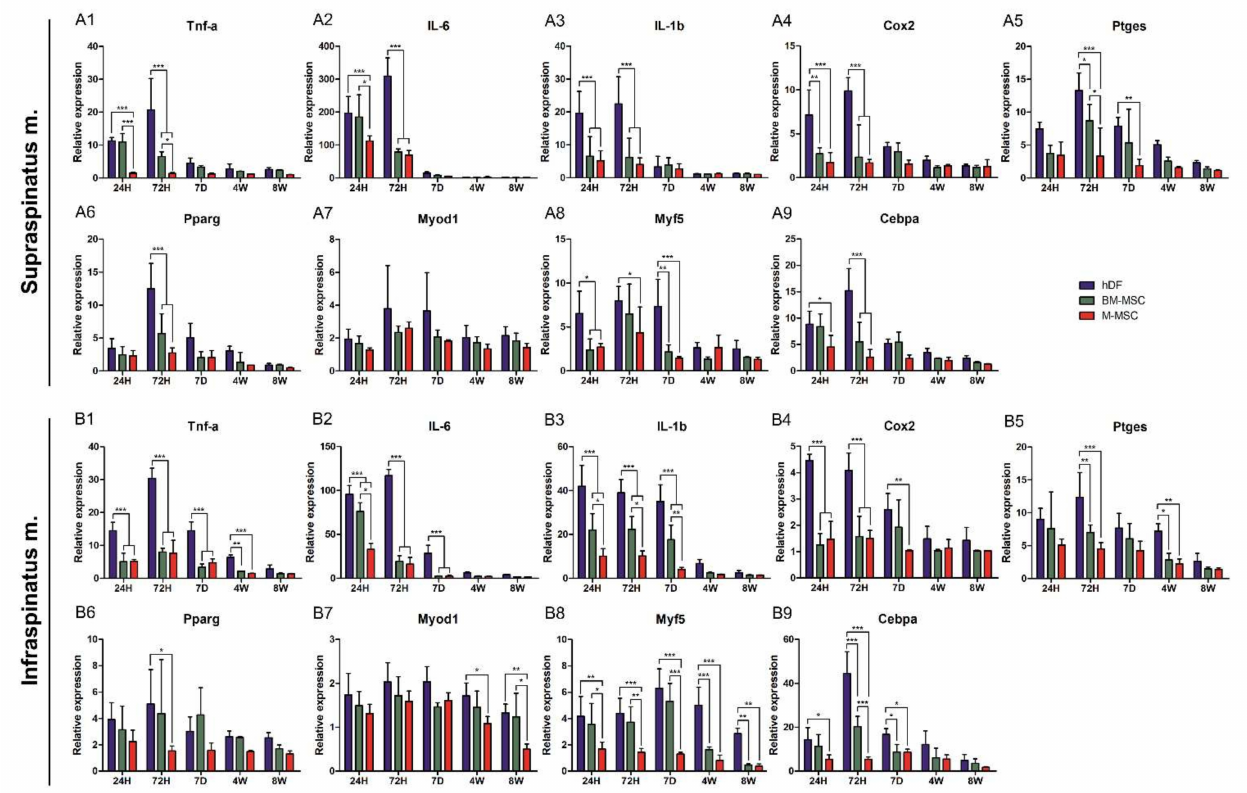
Figure 5. Relative expressions of genes related to inflammation, adipogenicity, and myogenicity. Supraspinatus and infraspinatus muscles were excised from hDF (control), BM-MSC and M-MSC groups at 24 h, 72 h, 7 days, 4 weeks, and 8 weeks after RCT induction. Genes related to in- flammation including ( A1 , B1 ) TNF-a, ( A2 , B2 ) IL-6, ( A3 , B3 ) IL-1b, ( A4 , B4 ) Cox2 and ( A5 , B5 ) Ptges were monitored while adipogenic genes ( A6 , B6 ) Pparg and ( A7 , B7 ) Myod1, and myogenic genes ( A8 , B8 ) Myf5 and ( A9 , B9 ) Cebpa were monitored. The data are shown as mean ± SE and the significance was represented as * p < 0.05; ** p < 0.01; *** p < 0.001,